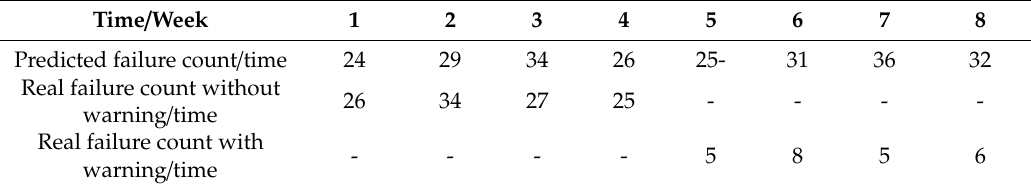
Table 5. A comparison of real failure counts with and without warning.